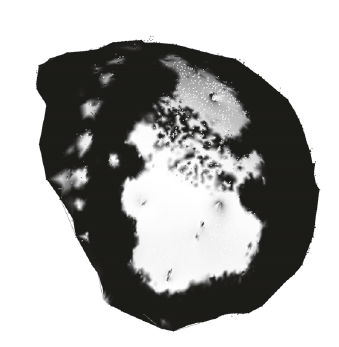
Figure 6: The grayscale 3D surface after color reconstruction based on binary segmentation mask